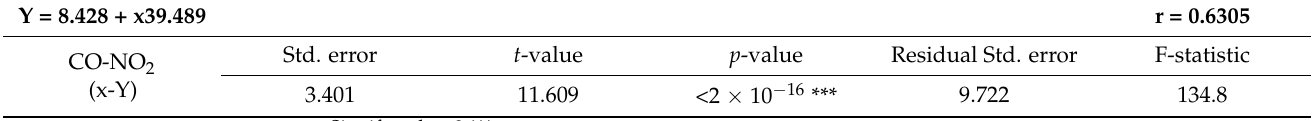
Table 4. Summary statistics from linear regression model for CO and NO 2 .